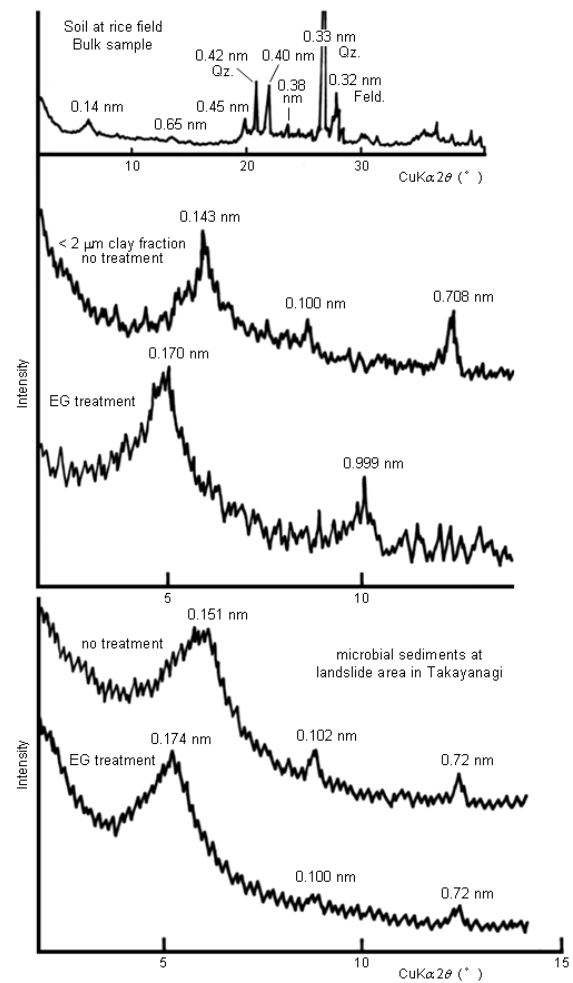
Fig. 5 – X-ray powder diffraction patterns of ricefield soils in Niigata andmicrobialmatsatlandslideareainTakayanagi, Niigata, showingbulk and < 2 µ m fraction data with no treatment and after E.G.